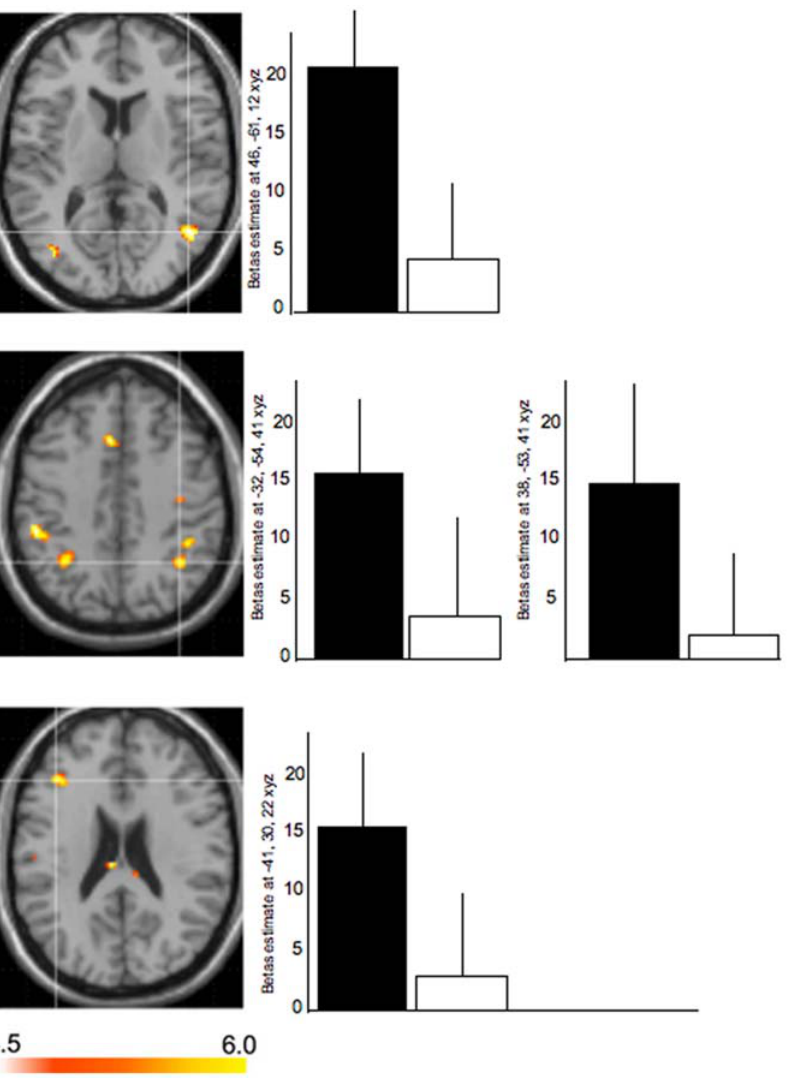
Figure 3. fMRI neuroimaging results for intentions. Functional MRI results when participants saw repeated actions with the same intentions (action goals). RS was observed in the following areas. Top panel: right MTG/STS (46, 2 61,12 x, y, z MNI coordinates; Z: 4.12), Middle panel: bilateral aIPS (left: 2 32, 2 54,41 x, y, z MNI coordinates; Z value: 3.3; right: 38, 2 53,41 x, y, z MNI coordinates; Z value: 3.45). Bottom panel: left inferior frontal gyrus ( 2 41,30,22 x, y, z MNI coordinates; Z value: 3.47). Weaker areas are reported in Table 2. BOLD responses are shown on axial views.